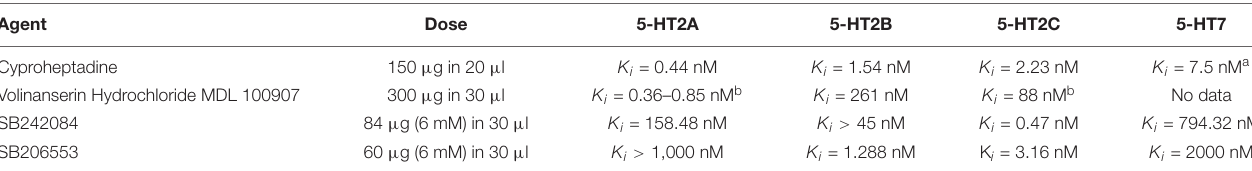
TABLE 1 | Chemical agents used for intrathecal